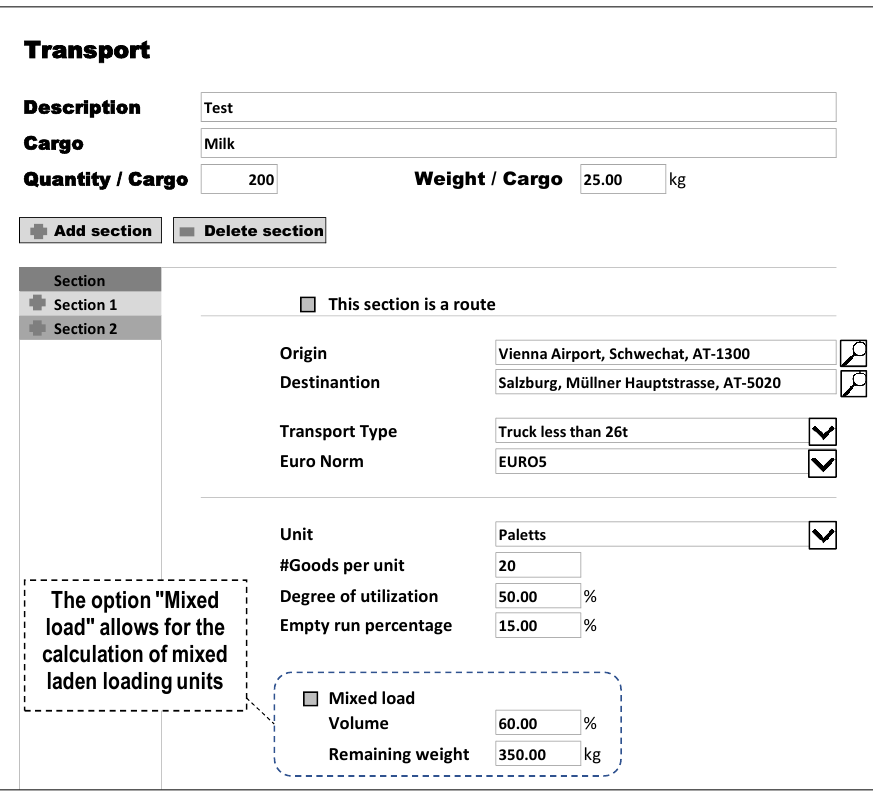
Fig. 3. Input Section